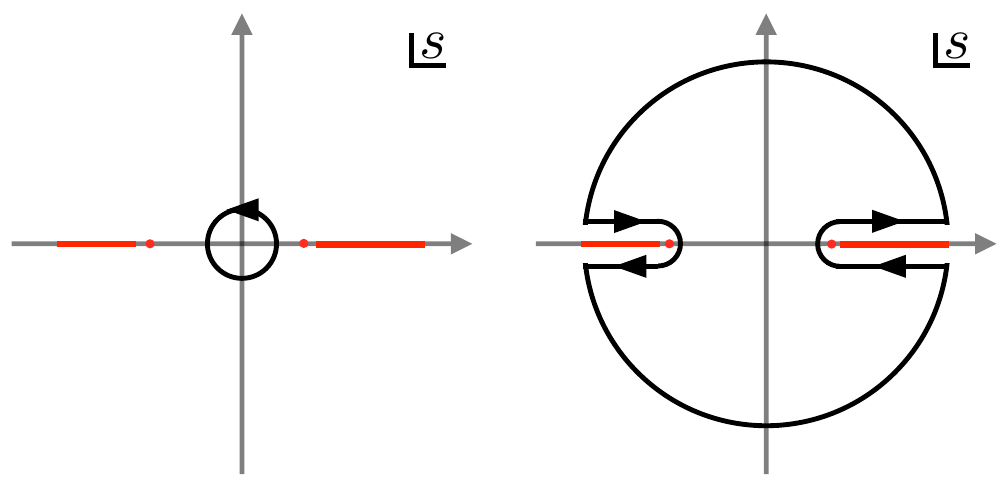
Figure 1 . Integration contour and analytic structure: The red lines represent branch cuts associ- ated to multi-particle states generated by loops, whereas the red dots are single poles associated to single-particle states. The left panel is the integration contour used to read o(cid:11) the IR coe(cid:14)cients. By deforming it into the one on the right panel, we may clarify how the UV data is encoded into the IR